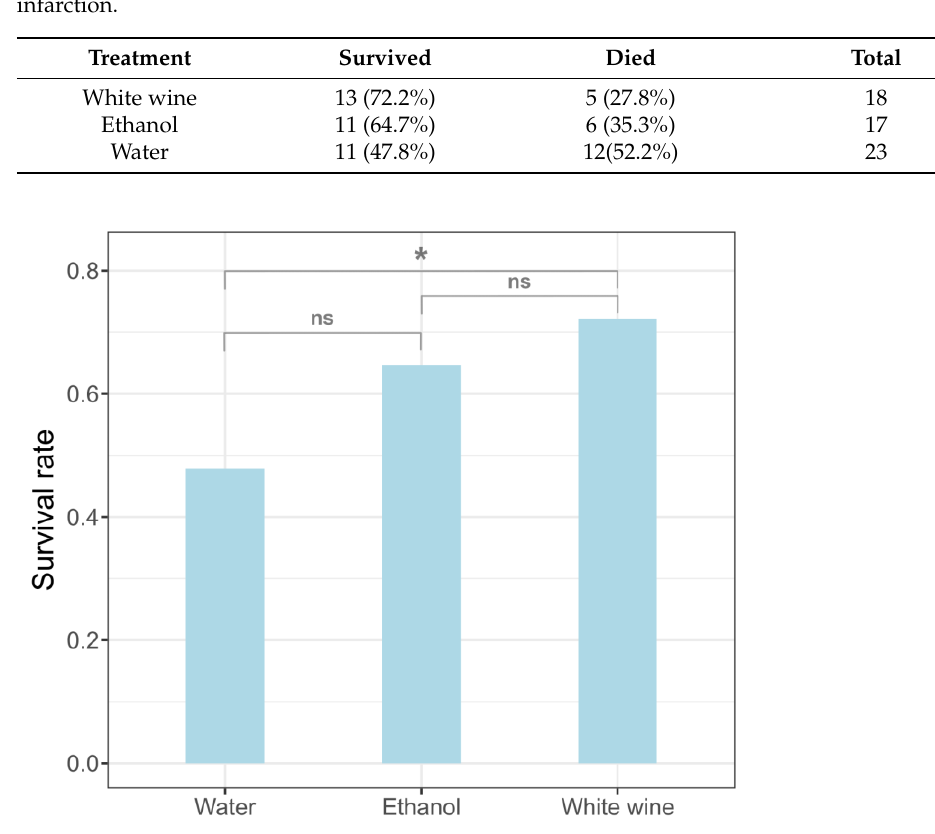
Figure 3. Comparison of survival rates between groups of rats drinking white wine, 13% ethanol or water only. NS = not significant. * denotes a p -value between 0.01 and 0.05.